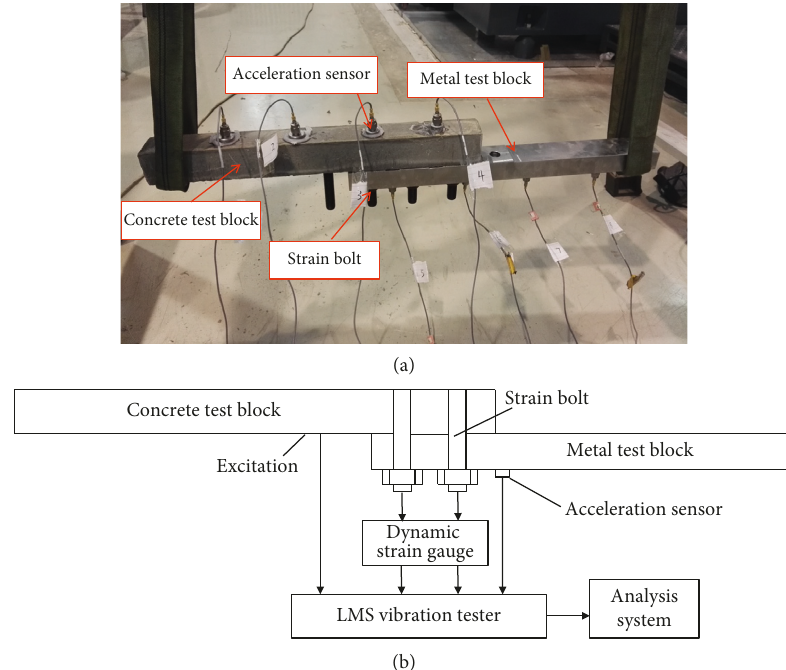
Figure 5: Basic experimental setup of the tool metal-concrete system. (a) Photograph of the test setup. (b) Schematic diagram of the test